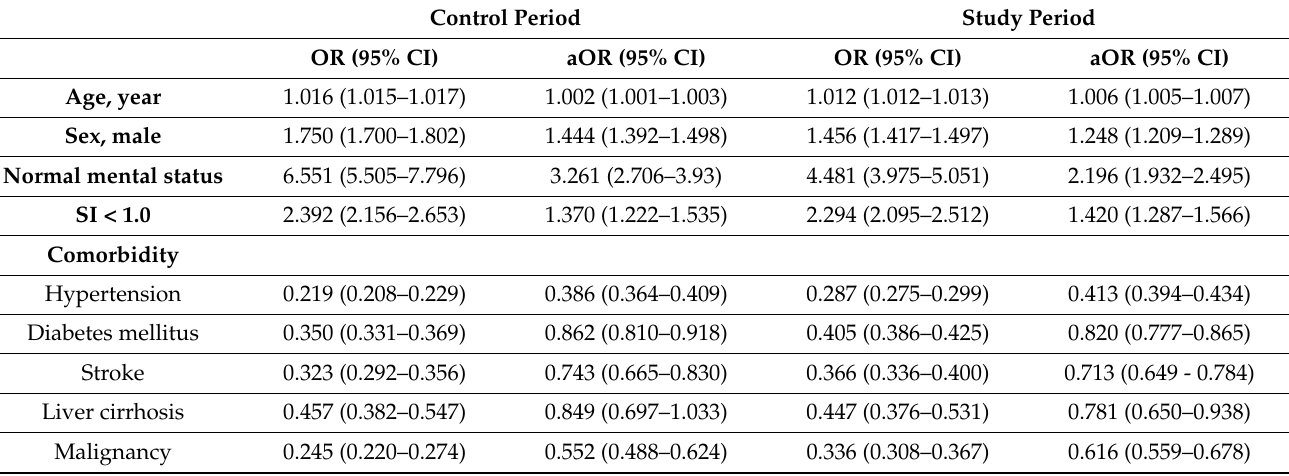
Table 2. Unadjusted and adjusted comparisons of refusal rates for EMS transport between the control period and study